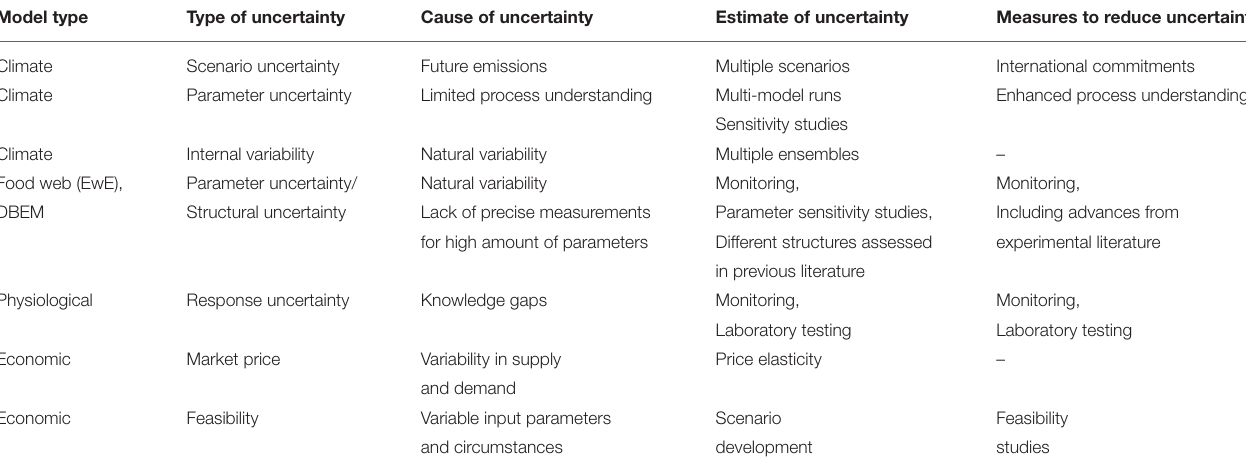
TABLE 4 | Uncertainties in coupled climate-ecosystem-economic (CEE) models. Model